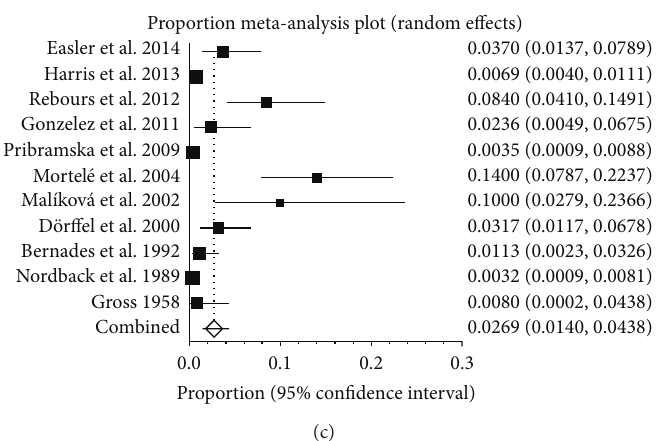
Figure 3: (a) Forest plots showing the prevalence of portal vein thrombosis (PVT) in pancreatitis. (b) Forest plots showing the prevalence of splenic vein thrombosis (SlpVT) in pancreatitis. (c) Forest plots showing the prevalence of mesenteric vein thrombosis (MVT) in